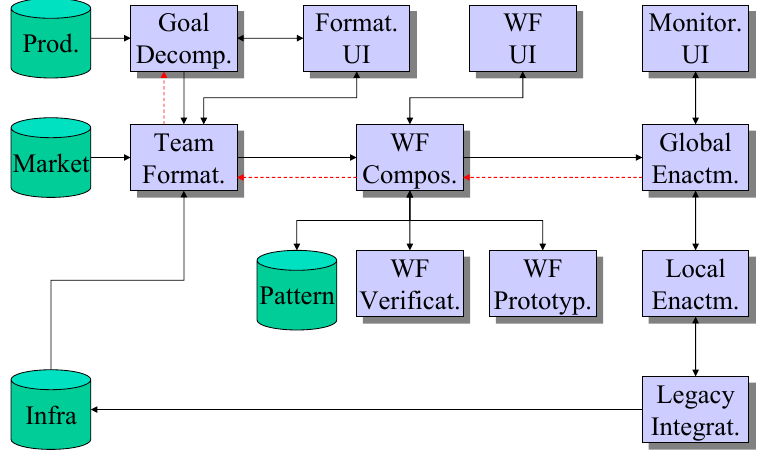
Figure 10. CrossWork system architecture [23].